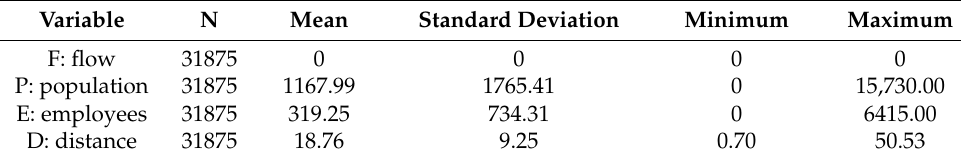
Table 5. Descriptive Statistics for Zero Flows in